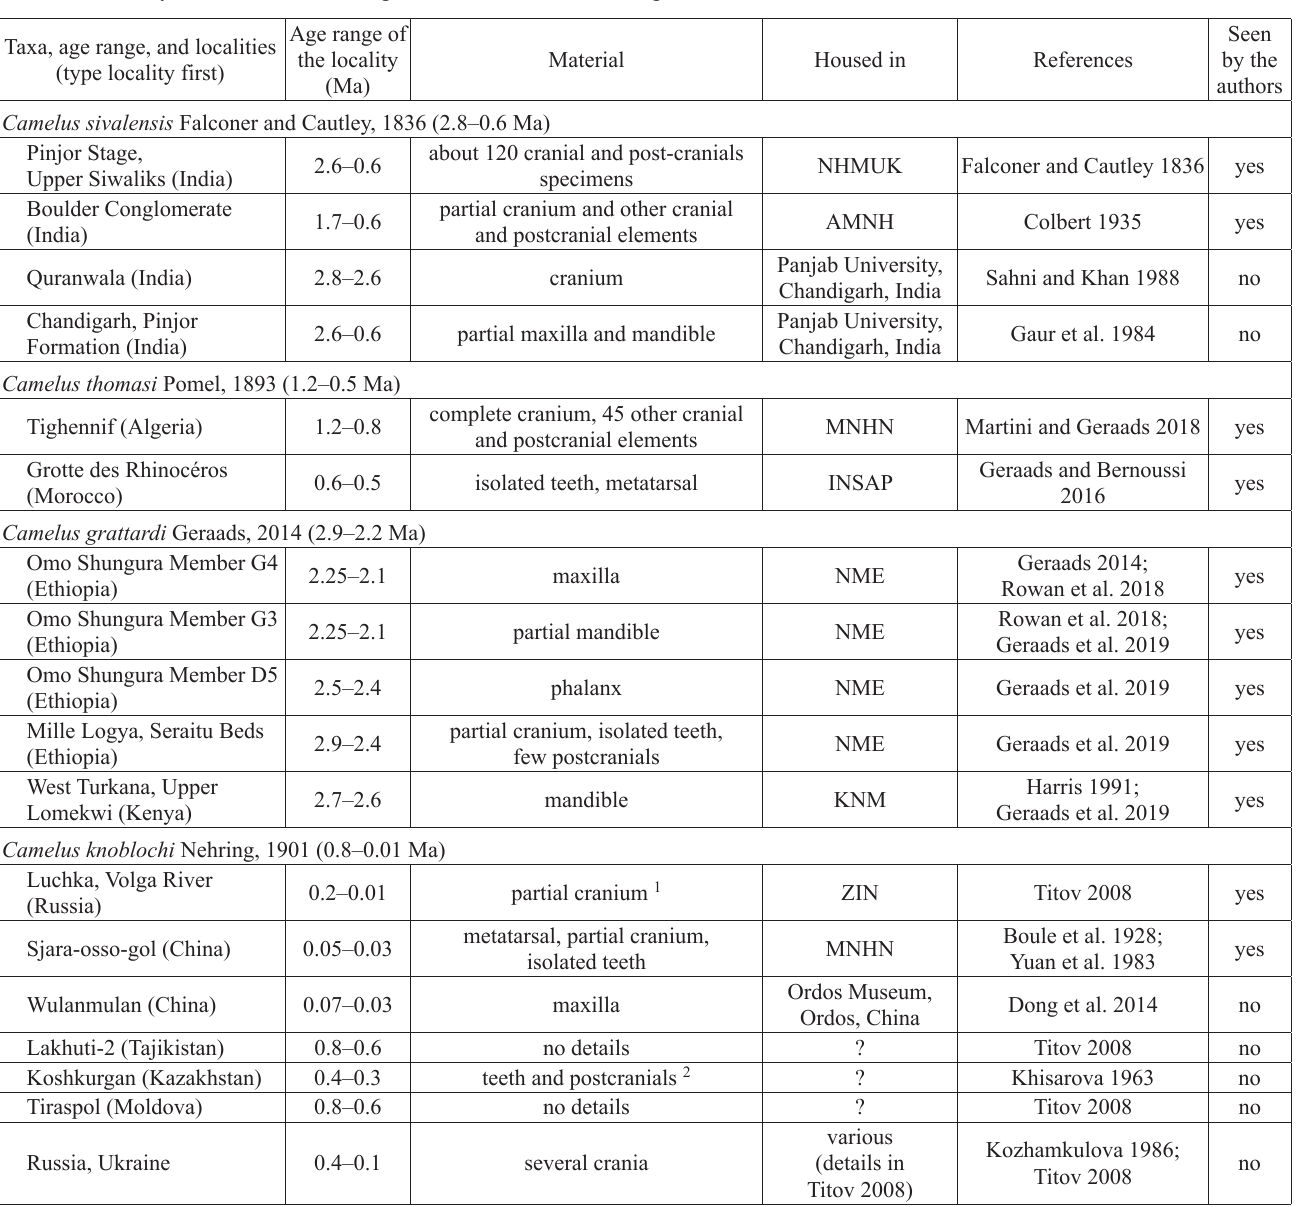
Table 1. List of the records used in “DateFBD”. We list only those records that can be identified to species with good confidence; this explains why a number of Camelus records, even if identified to species by other authors, are left aside. Note that several of the dates are only biochronological estimates. The data that are actually used in the analysis (see SOM 1) are in the second column. Notes: 1 the type-specimen is hardly fossilized; 2 identified as Paracamelus gigas , but certainly incorrect; 3 species identification likely, but not quite certain; 4 the earliest and most reliable record for the living species; 5 no associated fauna reported; age probably within the 6.2–3.45 Ma range; 6 Plio-Pleistocene (= early Pleistocene in mod- ern terminology) for Teilhard de Chardin and Trassaert (1937), but with little support; contemporaneous with Dinofelis abeli , dated by Werdelin and Peigné (2010) 4.5–3.5 Ma; 7 Chron C2An; 8 stratigraphic origin (“Pontian”) very uncertain; associated with zygolophodont mastodont